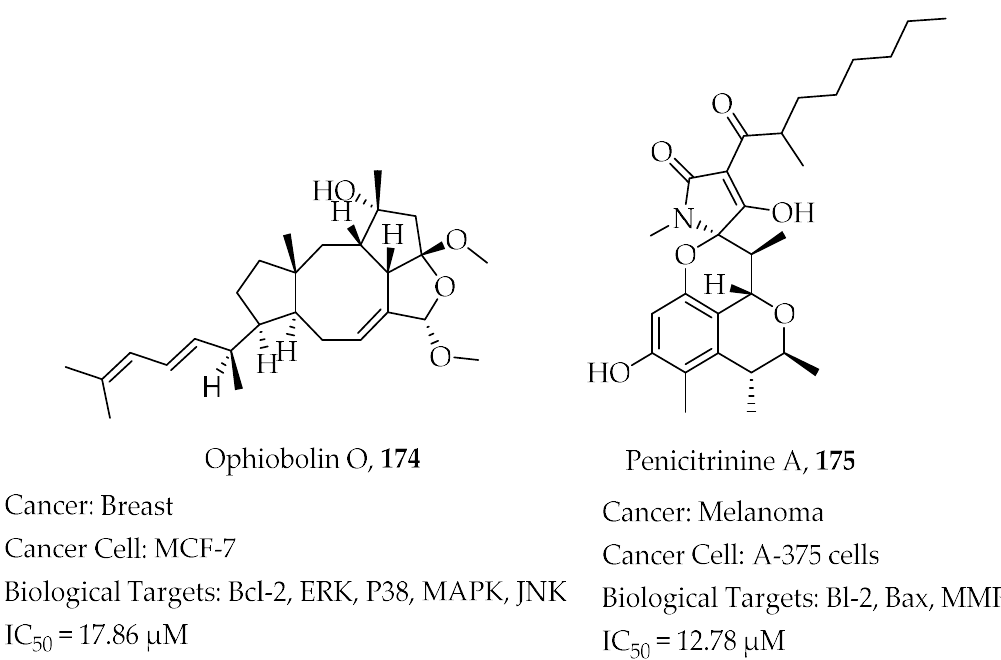
Figure 44. Structures of the sestertepenoid Ophiobolin and the spiro alkaloid Penicitrinine A with a summary of their biological activity towards selected cancer targets.